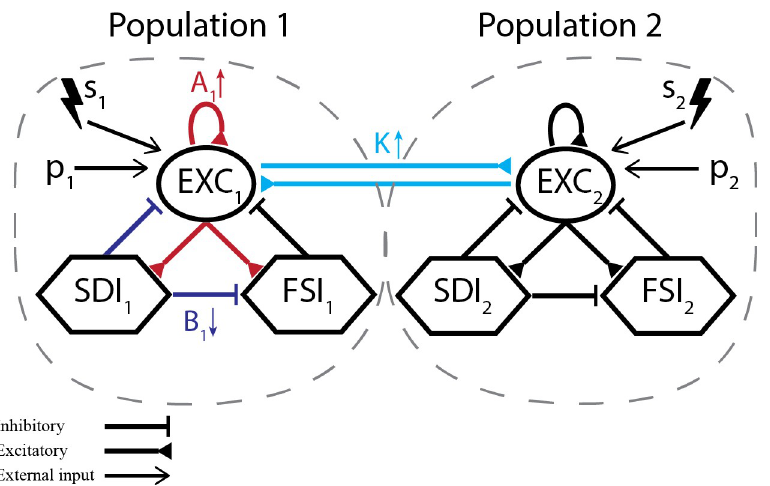
) or (II) simultaneous bilateral low-frequency 2